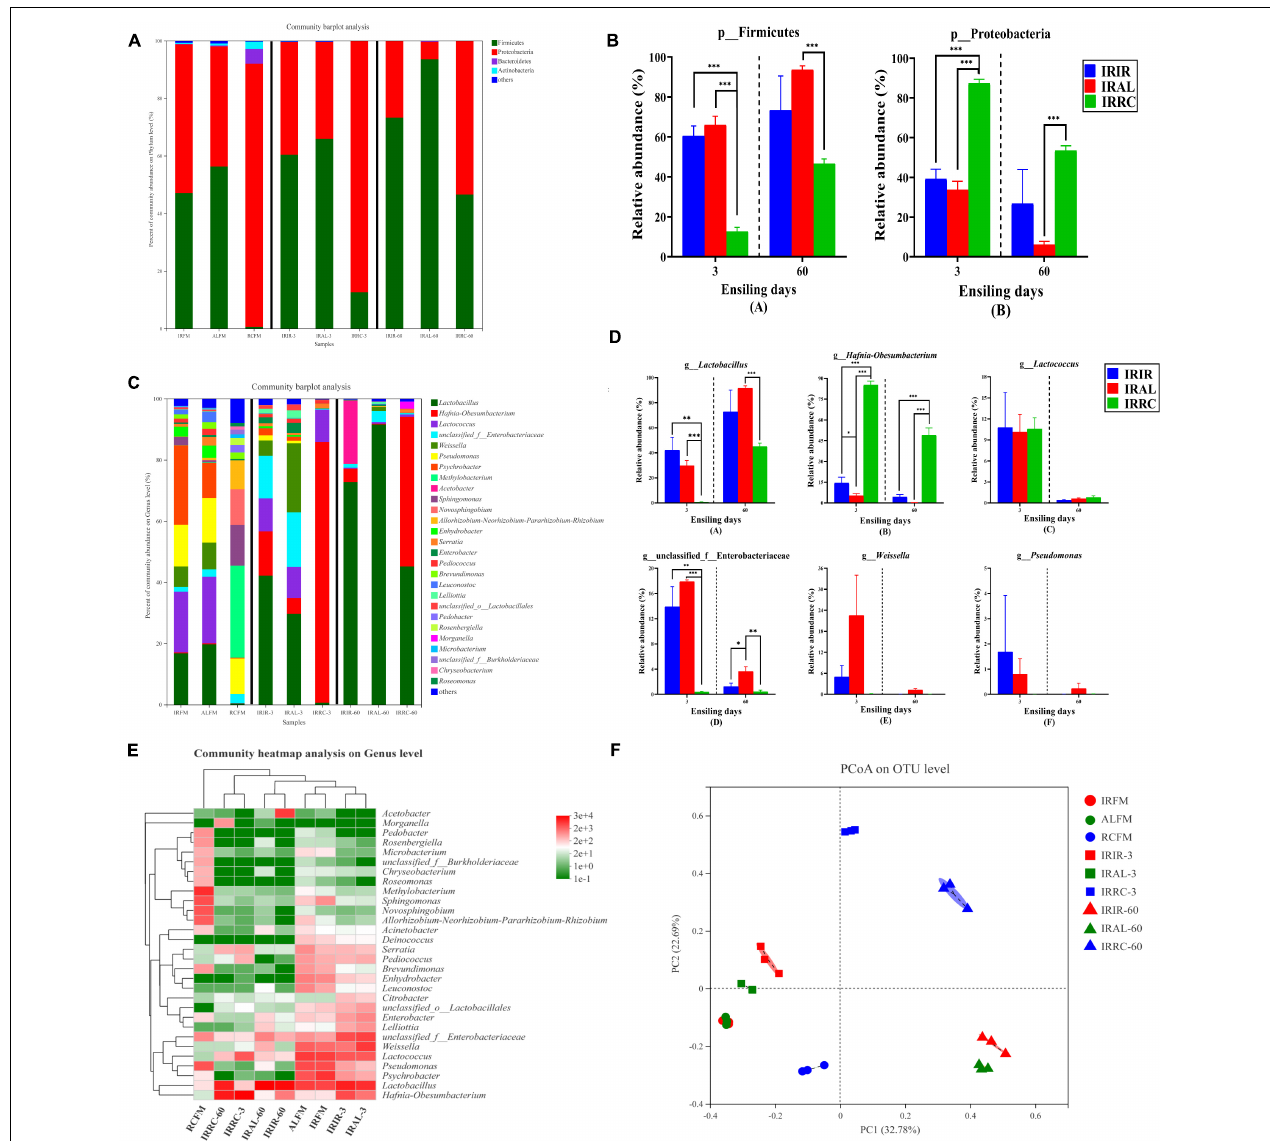
FIGURE 2 | Phylum and genus level compositions (A–D) of the bacterial community in Italian ryegrass silages. (E) Community heatmap analysis on genus level. (F) Principal coordinate analysis (PCoA) plot on operational taxonomic unit (OTU) level. IRFM, fresh material of Italian ryegrass; ALFM, fresh material of alfalfa; RCFM, fresh material of red clover; IRIR, sterile Italian ryegrass inoculated by epiphytic bacteria from Italian ryegrass; IRAL, sterile Italian ryegrass inoculated by epiphytic bacteria from alfalfa; IRRC, sterile Italian ryegrass inoculated by epiphytic bacteria from red clover; 3, 3 days of ensiling; 60, 60 days of ensiling. ∗ , 0.01 < p < 0.05; ∗∗ , 0.001 < p < 0.01; ∗∗∗ , p <